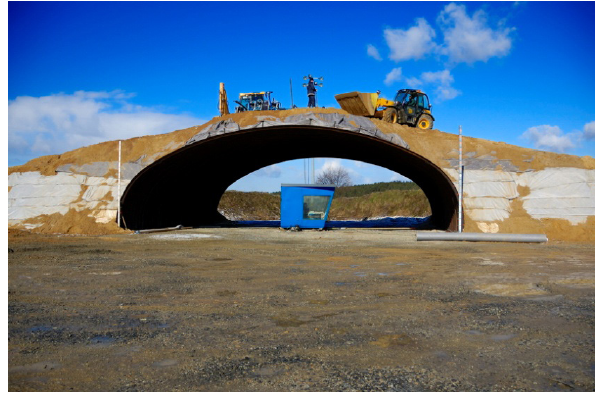
Figure 1 : Loads occurring during the construction of soil-steel